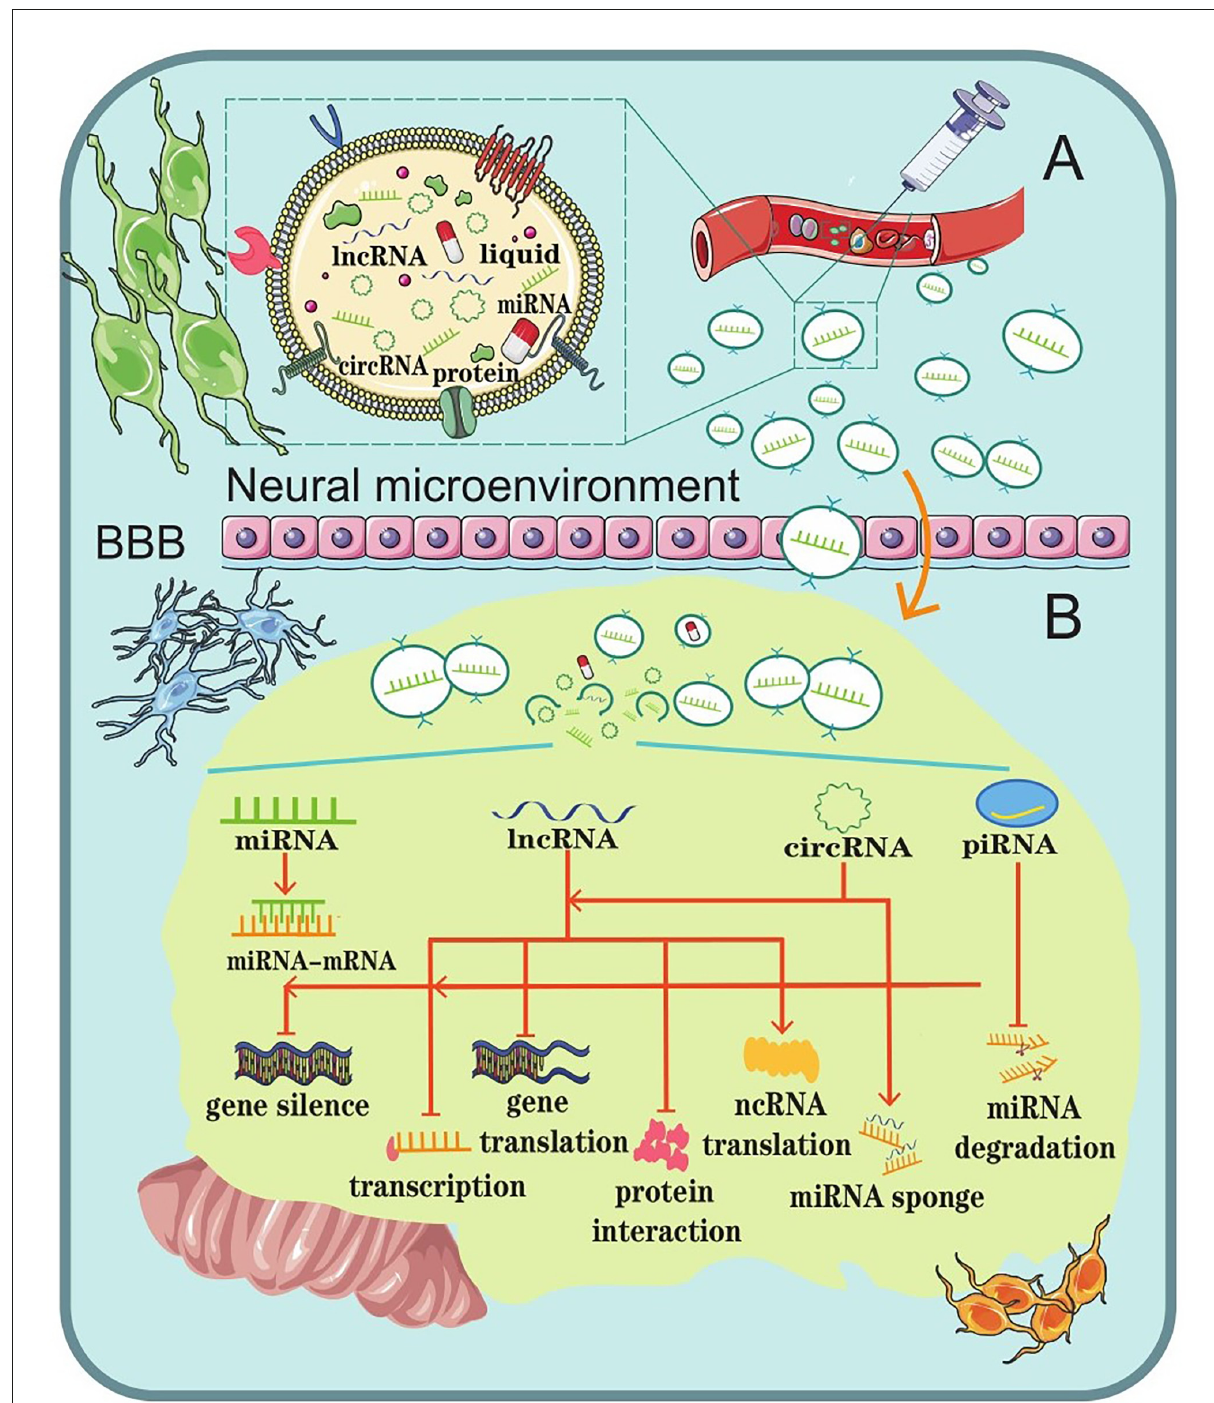
FIGURE3 Schematic representation of the role of exosomal ncRNAs as a potential therapeutic strategy for CNS diseases. (A) Liposoluble exosomes can cross the BBB easily. They are intended as natural nanoscale vesicles; therefore, they can be engineered to delete vehicles that contain specific drugs or biological ncRNAs. (B) The biological functions of exosomal ncRNAs in the brain